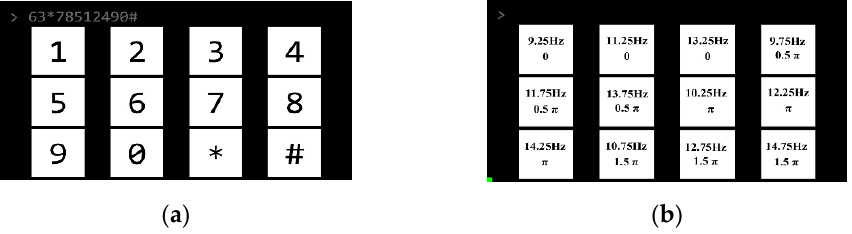
Figure 1. ( a ) Stimulation interface of the 12-target brain-computer interface (BCI) speller. ( b ) Fre- quency and phase values for all targets. quency and phase values for all